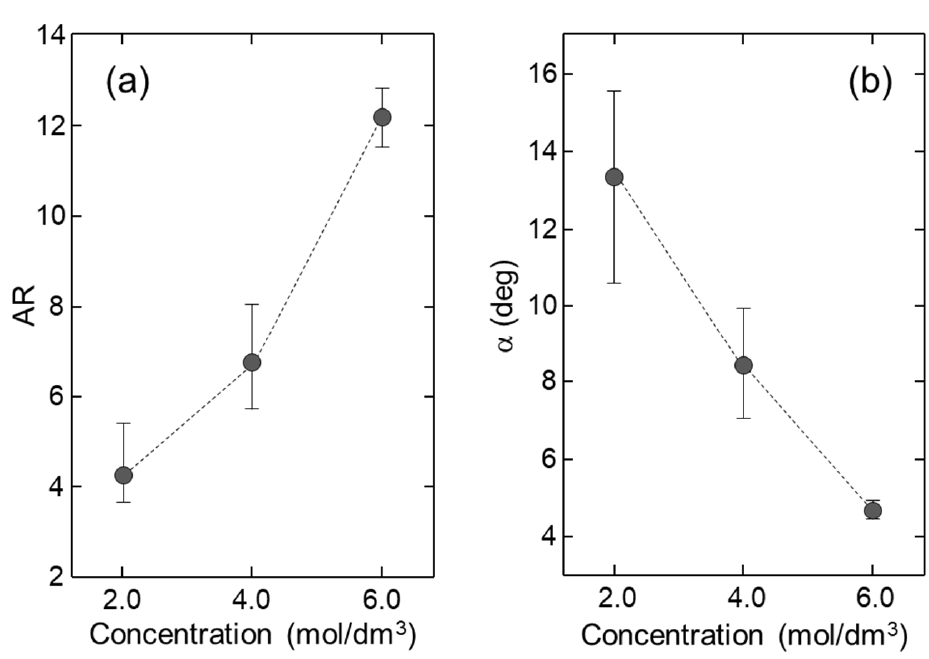
Figure 5. Dependence of ( a ) the AR and ( b ) α of the conical pores on the concentration of the aqueous NaOH solution. Both of the values were calculated using the data in Figure 4a,b, which were obtained from the experiments at all of the etching times.